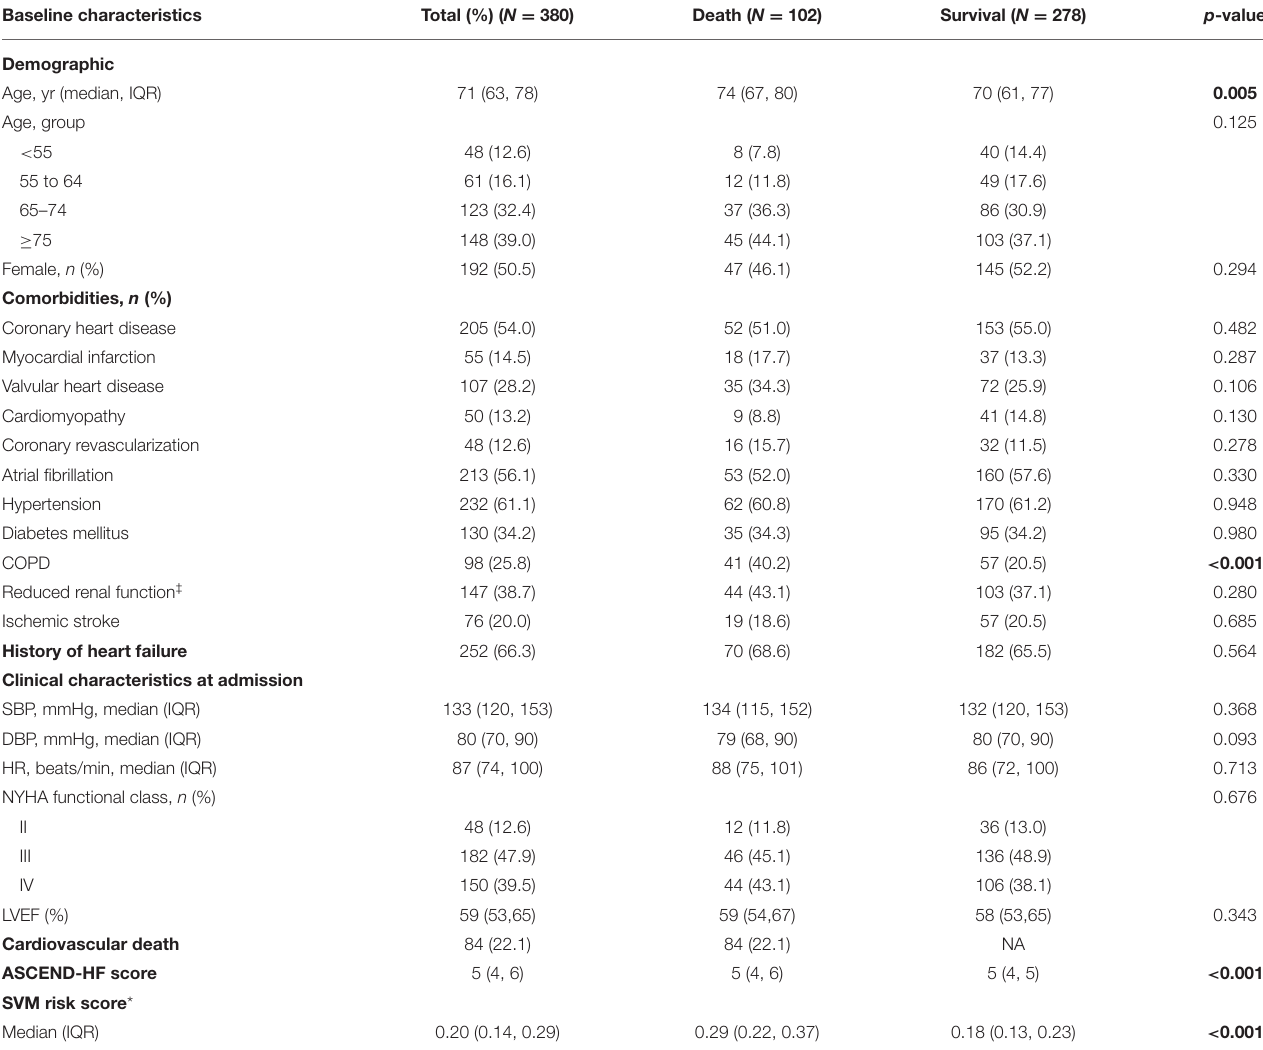
TABLE 1 | Baseline characteristics stratified by survival status at 2-years after index admission. Baseline